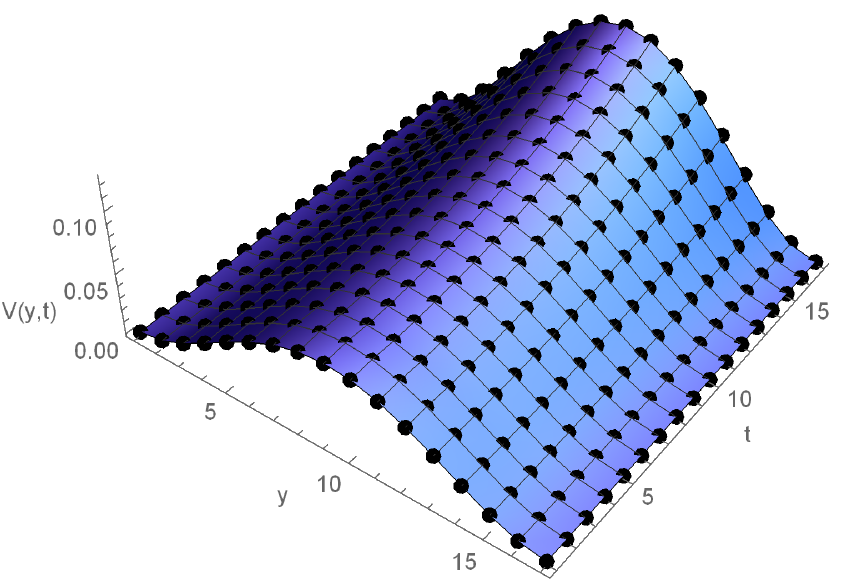
Figure 2 . Comparison of the exact (dots) and the computed values (solid lines) of Example 1 at γ = 0.5 and α =